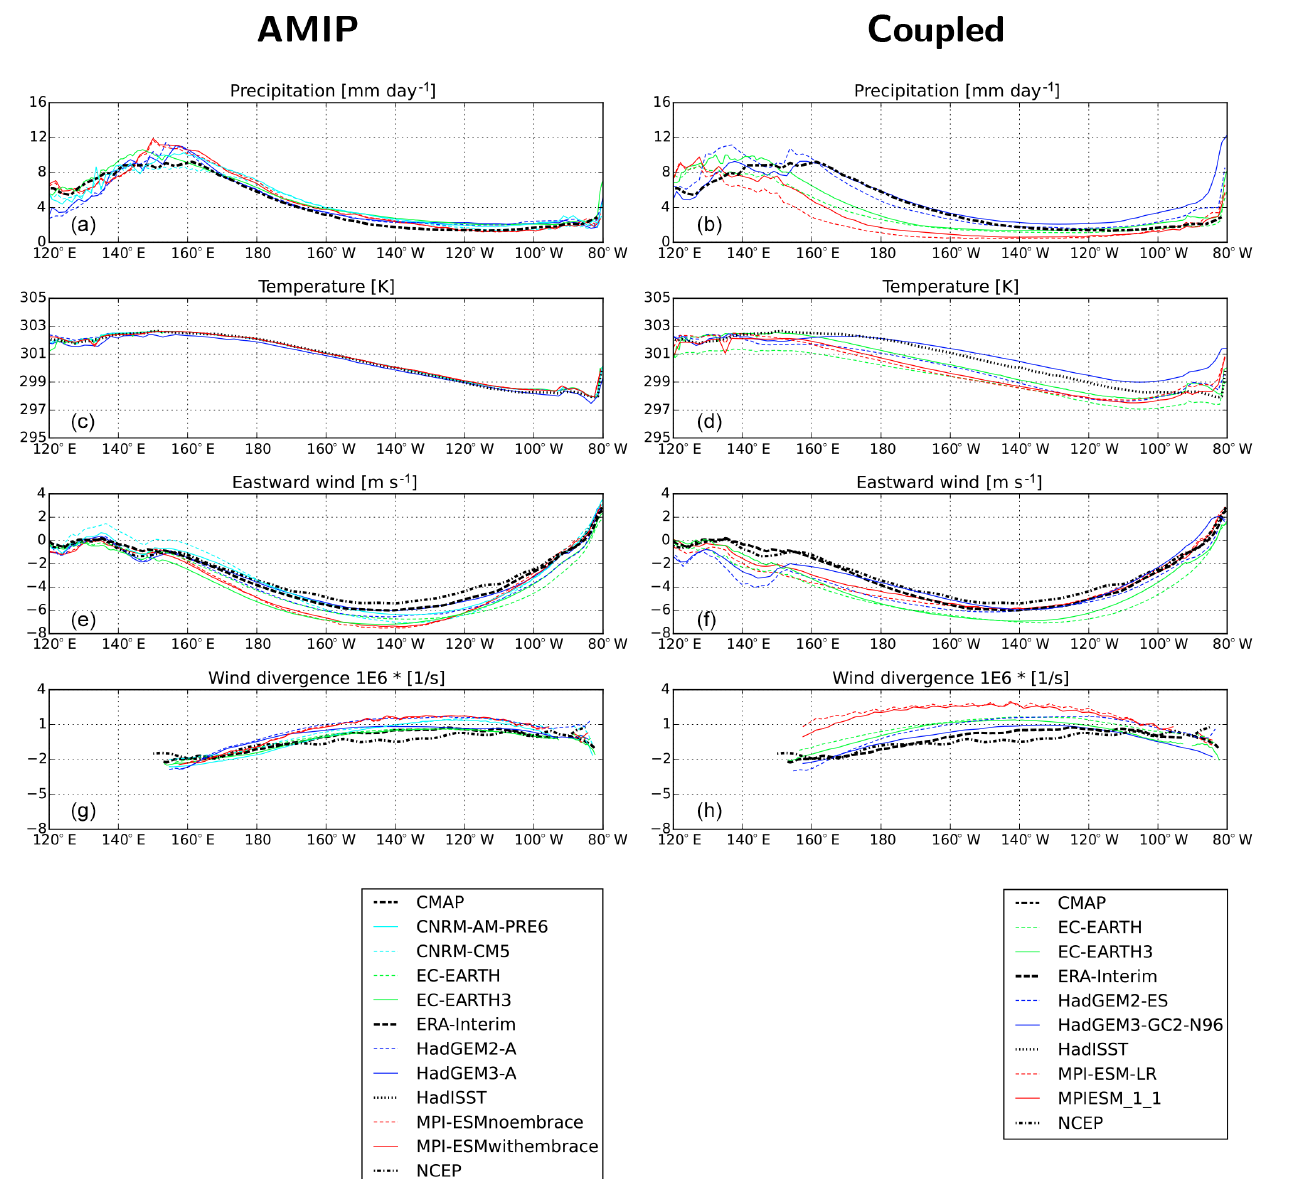
Figure 15. Equatorial mean (2.5 ◦ N to 2.5 ◦ S) values from top to bottom panels: precipitation, SST, 1000hPa zonal wind speed, and total 925hPa wind divergence averaged over the years 1982–2002 (MPI AMIP models 1979–1999). Values are plotted for the equatorial Pacific between 120 ◦ E and 80 ◦ W. The left column panels show model results from the AMIP simulations, the right column panels from the coupled (historical) simulations in comparison with